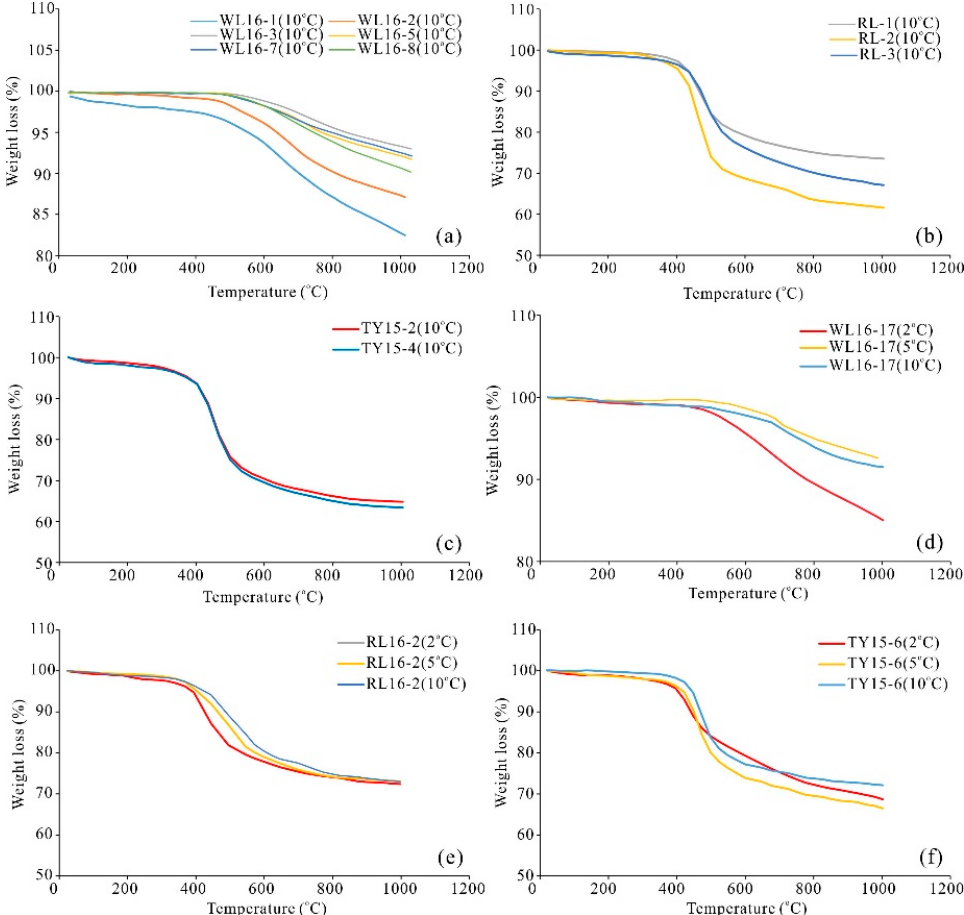
Figure 8. Weight loss at 10 °C/min ( a – c ) and various heating rates ( d – f ) of coal samples for the Wolonghu, Taoyuan and Renlou coal mines in the Huaibei Coalfield.